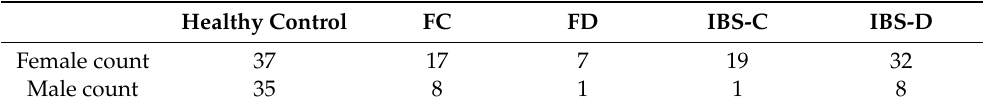
Table 1. Participant number and gender. Abbreviations: healthy control, functional constipation (FC), IBS-constipation (IBS-C), functional diarrhea (FD), and IBS-diarrhea (IBS-D).